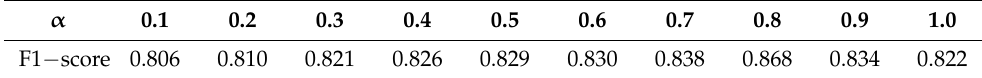
Table 4. Detection accuracy of red tides for different α .